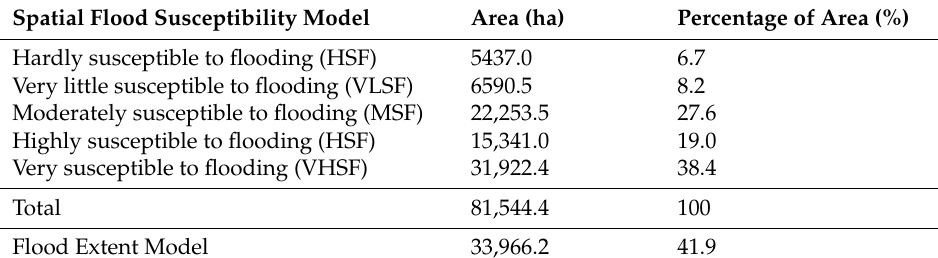
Figure 7. ( A ) Flood extent extraction model of November 2010 flood in Perlis state; ( B ) flood susceptibility map using ANP model. Table 7. Susceptibility levels of spatial flood susceptibility model and the magnitude of flood extent model.